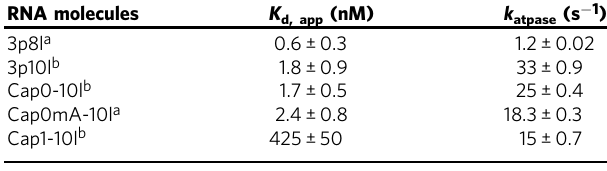
Table 1 RNA binding and ATPase activity of WT